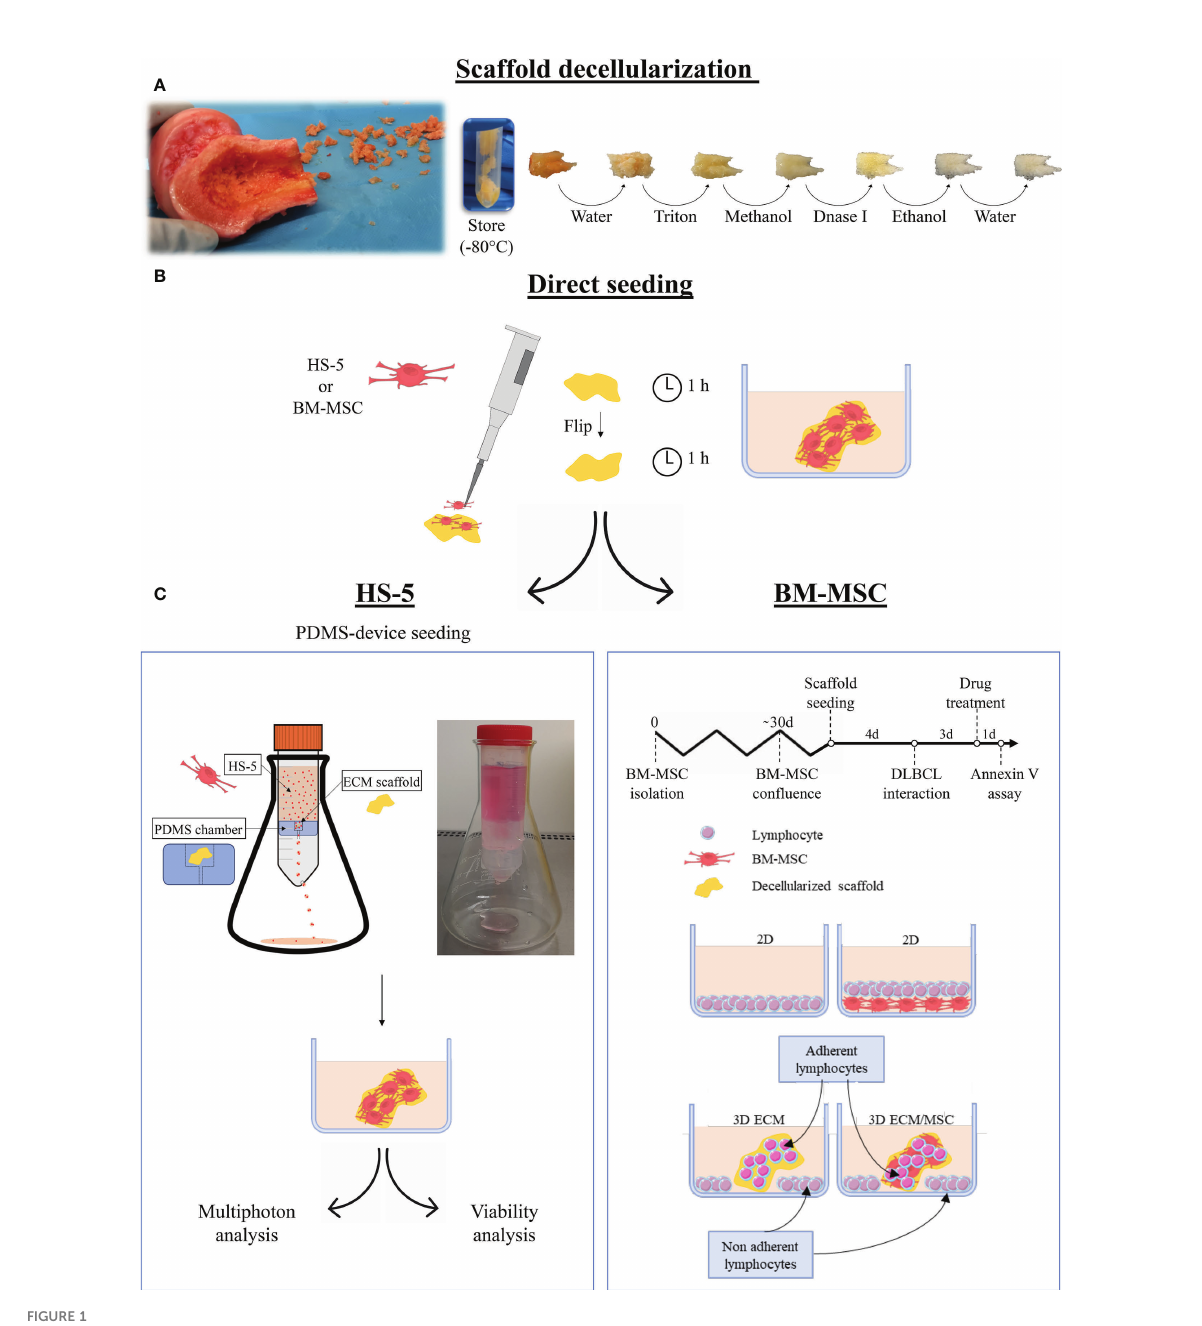
FIGURE 1 Schematization of the main phases of the study. (A) Following fragmentation of human femoral bones, fragments were decellularized with complete removal of cellular components. (B) The fragments were then recellularized with HS-5 or bone marrow mesenchymal stromal cells (BM-MSC) by direct seeding, placing half of the amount of cells on each side of the fragment. The cell culture medium was added after an additional incubation hour. The following steps depended on the cells used for the recellularization: (C) left panel: HS-5 recellularized fragments underwent polydimethylsiloxane (PDMS) device seeding (double-step seeding procedure) to improve and streamline the recellularization. The PDMS device consisted of a PDMS chamber containing the bone scaffold, placed in a 50-ml Falcon tube holed at the base. The HS-5 cell suspension fl owed by gravity through the PDMS chamber, allowing the cell to adhere to the scaffold. The models realized through the HS-5 double-step seeding procedure were used for multiphoton analysis and viability assays. (C) Right panel: the BM-MSC recellularized model did not undergo double seeding by the PDMS device as one step recellularization was effective after 4 days of culture. DLBCL was then added and fragments were incubated for additional 3 days before drug treatment. Annexin V assay was performed after 24 h of treatment. For drug treatments, the following conditions were evaluated: a conventional 2D lymphocyte culture, a 2D lymphocyte/BM-MSC co-culture, a 3D culture of neoplastic lymphocytes only, and a 3D lymphocyte/BM-MSC co-culture. In the 3D systems, both adherent and non-adherent lymphocytes were analyzed. Pictures were partly created by